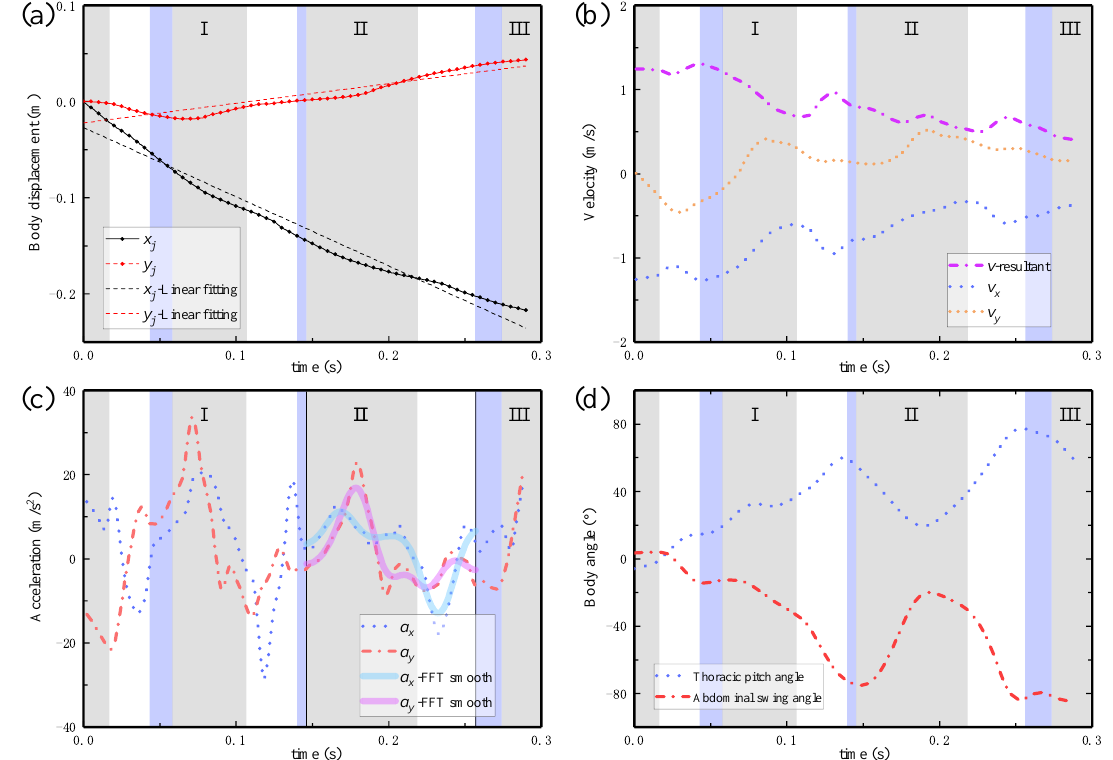
Figure 5. Time variations of body kinematics of VC1: ( a ) displacement of the joint point during forward flight; ( b ) velocity of the butterfly centroid (joint point); ( c ) acceleration of the butterfly centroid and FFT smoothing for the second flapping cycle; and ( d ) oscillation of thoracic pitch angle ( θ p ) and abdominal swing angle ( θ a ) . Grey shading indicates the DS, purple shading denotes the gliding moment, and white shading denotes the